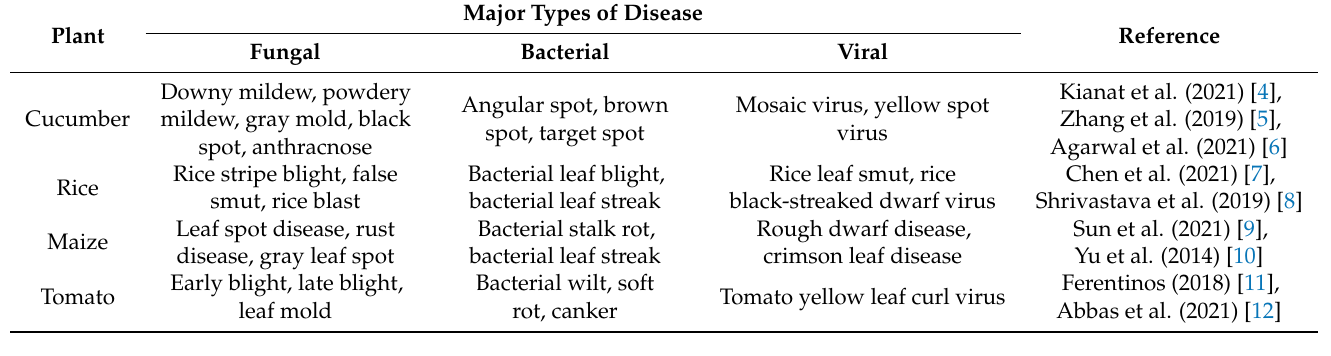
Table 1. Common diseases of several common plants.